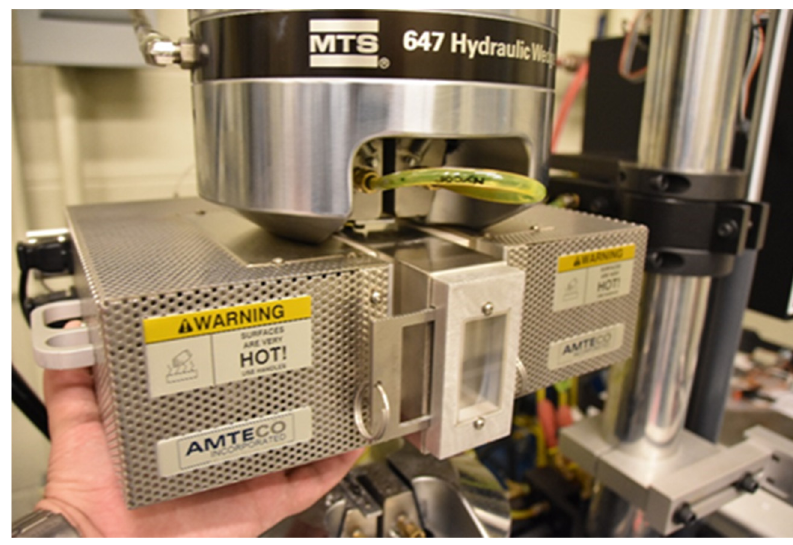
Figure 6. AMTECO high-temperature furnace with Sapphire view port.